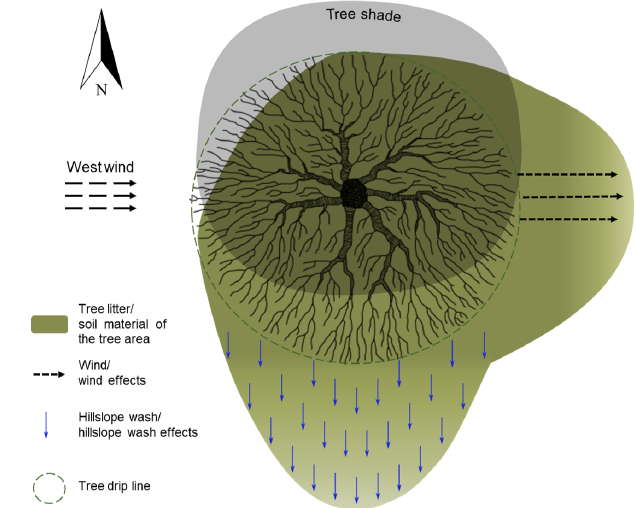
Figure 2. Potential spatial pattern of tree influence on the intertree